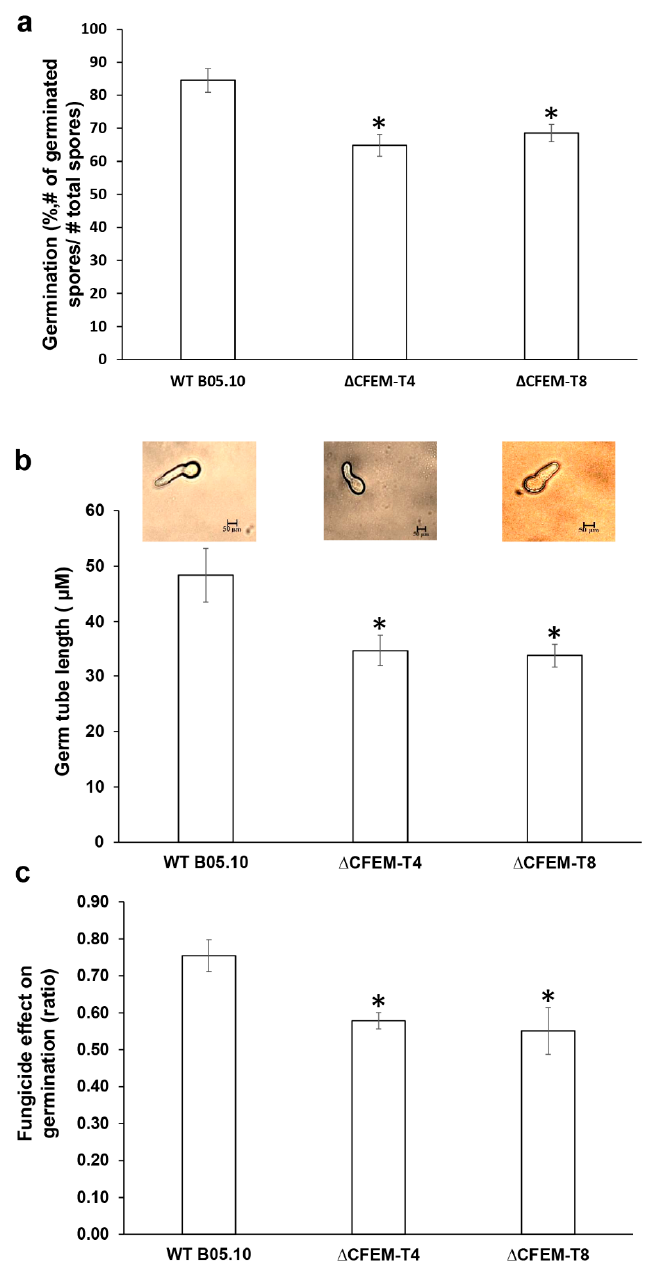
Figure 3. CFEM- Bcin07g03260 is required for conidial germination and germ tube elongation. ( a ) Average conidial germination (%) in the WT, ∆ CFEM-T4 and ∆ CFEM-T8. Germination was monitored in 1 PDB 4 at 20 ◦ C, 120 rpm in the dark. Germination (%) (Panel a) was calculated as (number of germinating conidia) / (total number of conidia). ( b ) Average germ tube length in the WT, ∆ CFEM-T4, and ∆ CFEM-T8 was calculated 6 h post inoculation in a similar condition to that described above. Photographs were taken at given time points, and germ tube length was measured using ImageJ software. ( c ) Conidial germination (%) in the presence of the fungicide pyrimethanil (2 mg / L). Conidial germination (panels a, and c ) was monitored in the presence or absence of the fungicide. The experiment was repeated three times ( n = 5 samples in each for conidial germination, and n = 50 for germ tube elongation). Error bars represent ± SE. Asterisks indicate significant difference between averages of the three different experiments ( p < 0.05, obtained by Student’s T-test). To calculate the effect of fungicide on conidial germination, the ratio was calculated as (germination in the presence of fungicide) / (germination in the absence of